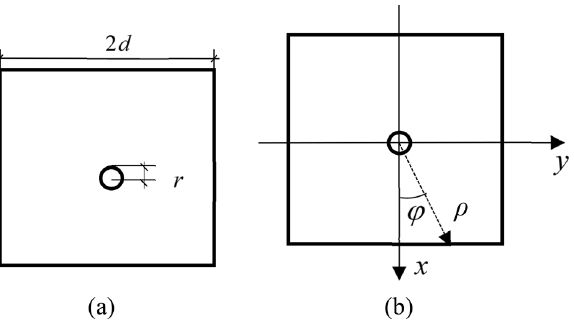
Figure 3. Specimen sketch. ( a ) Schematic diagram of specimen; ( b ) establishment of coordinate